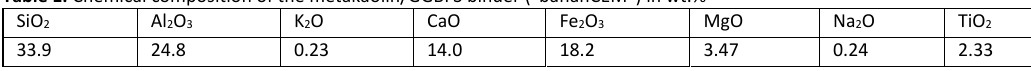
unit mix W ‐ GPM mix D ‐ GPM 270 232 kg/m³